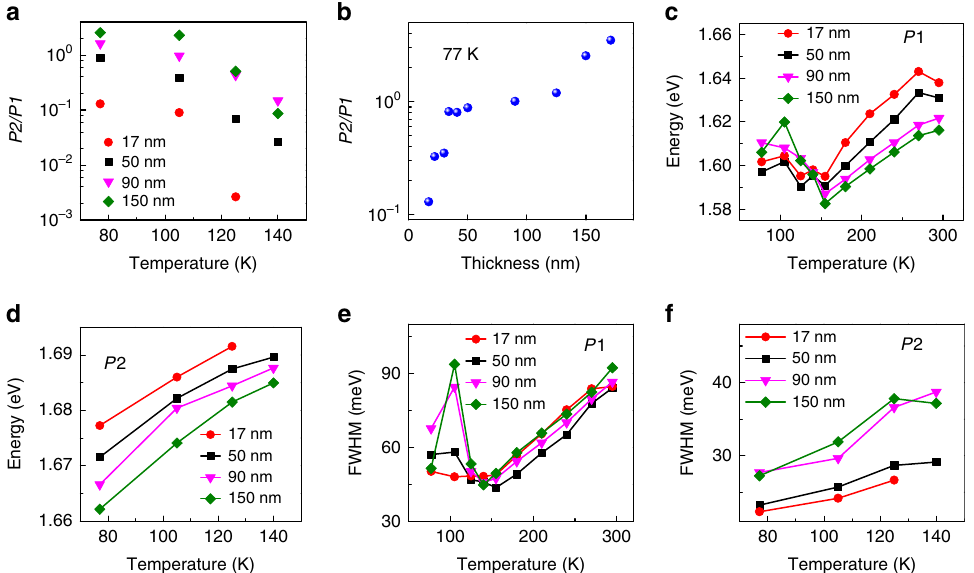
Figure 5 | The temperature- and thickness-dependent photoluminescence studies. ( a ) The temperature-dependent P 2/ P 1 ratios for a 17-, 50-, 90- and 150-nm-thick halide perovskite microplates excited by a 488-nm laser with a power of 3.5 m W. ( b ) The P 2/ P 1 ratios for halide perovskite microplates with various thicknesses at 77K. ( c , d ) The temperature-dependent emission energy for tetragonal phase ( c ) and orthorhombic phase ( d ). ( e , f ) The temperature-dependent full-width at half-maximum (FWHM) for tetragonal phase ( e ) and orthorhombic phase ( f ). NATURE COMMUNICATIONS|7:11330|DOI: